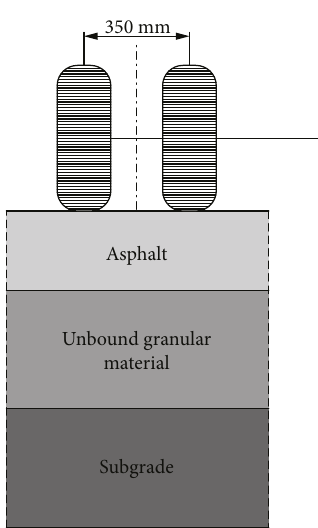
Figure 2: Cross section of the observed pavement